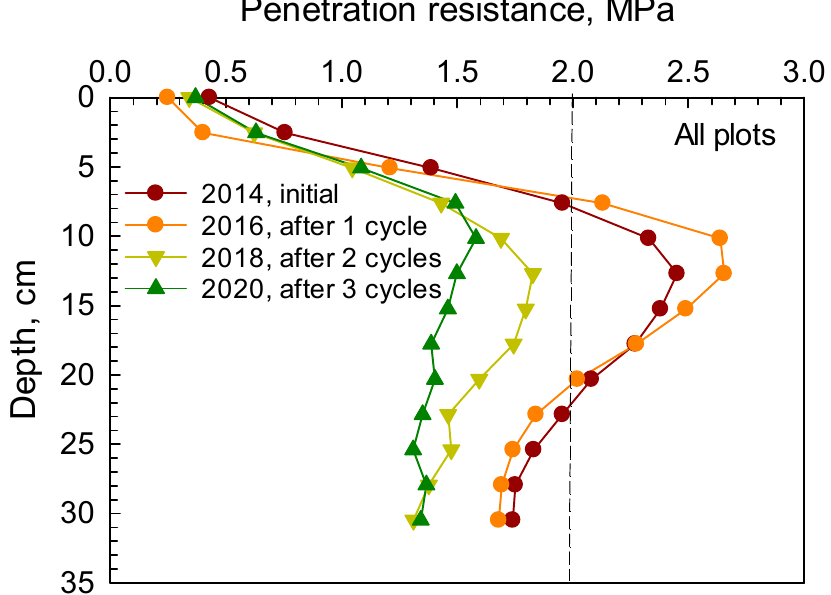
Figure 1. Initial mean soil penetration resistance across all plots in 2014, and across camelina, carinata, cover crop mix, and durum after 1 cycle in 2016, after 2 cycles in 2018, and after 3 cycles in 2020. Average soil penetration resistance across camelina, carinata, cover crop mix, and du- rum plots for the 8–20 cm layer after one, two, and three cycles of the 2 yr rotation